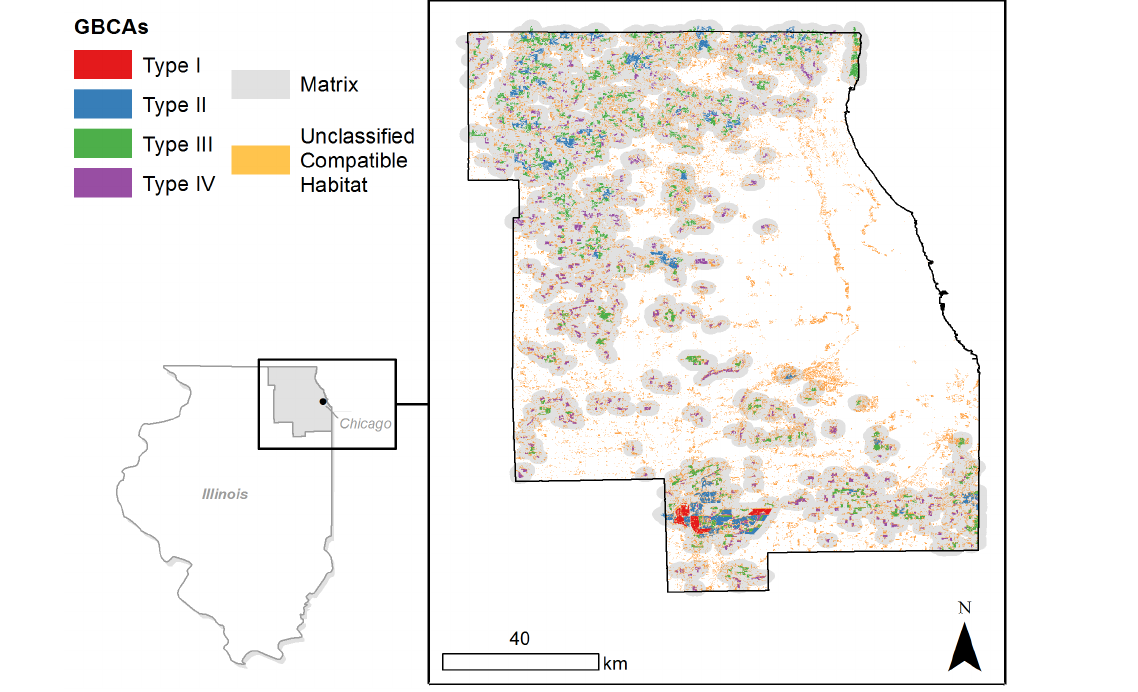
Fig. 1 . Type I–IV Grassland Bird Conservation Areas (GBCAs) in the Chicago Metropolitan Region. Type I GBCAs cover a total of 1933 ha; Type II GBCAs cover 11,938 ha; Type III GBCAs cover 25,343 ha; and Type IV GBCAs cover 15,778 ha. See Table 3 for definitions of GBCA types. White areas represent incompatible habitat.